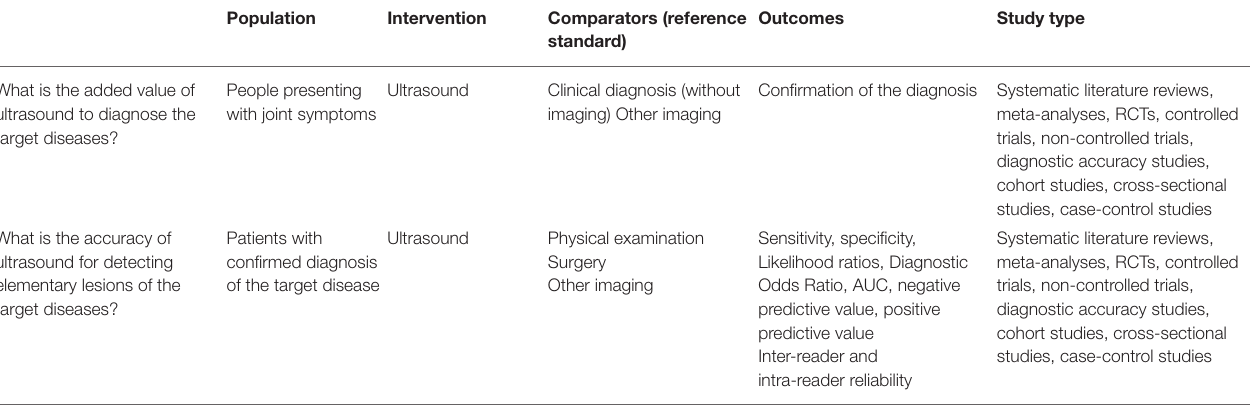
TABLE 1 | Inclusion criteria for research